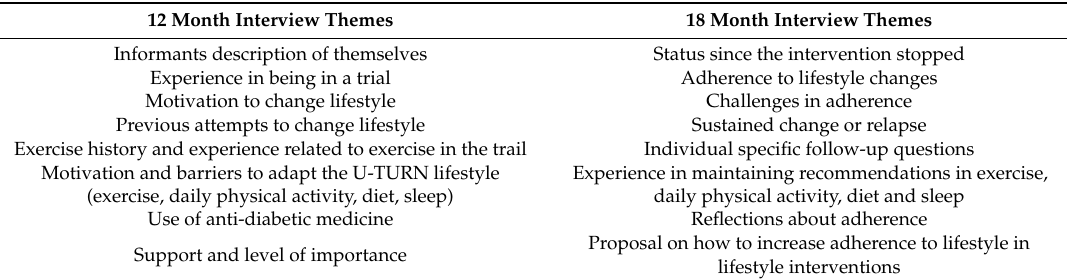
Table 3. Themes from interview